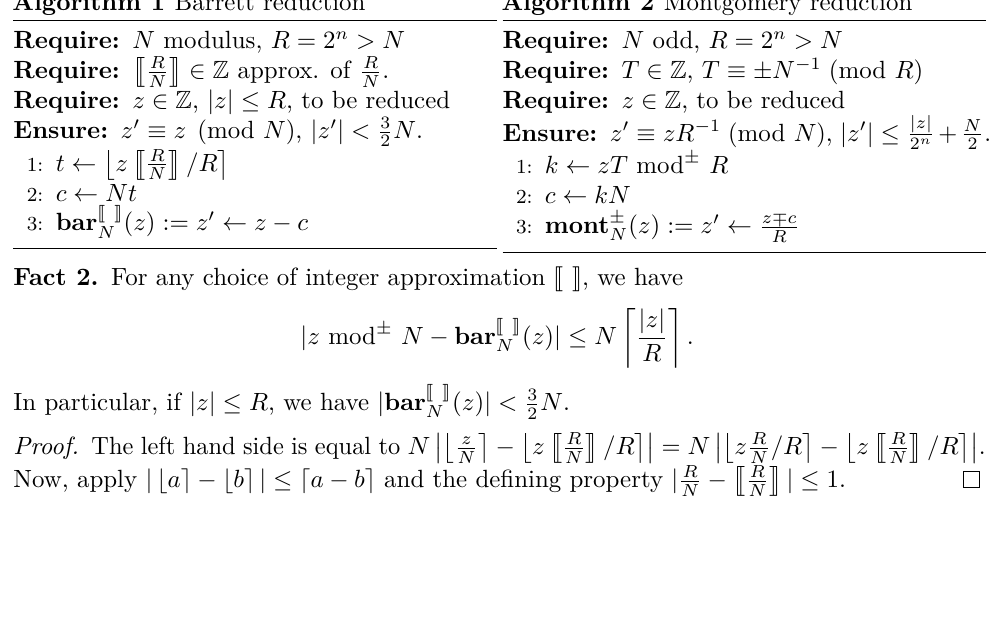
Algorithm 1 Barrett reduction Algorithm 2 Montgomery